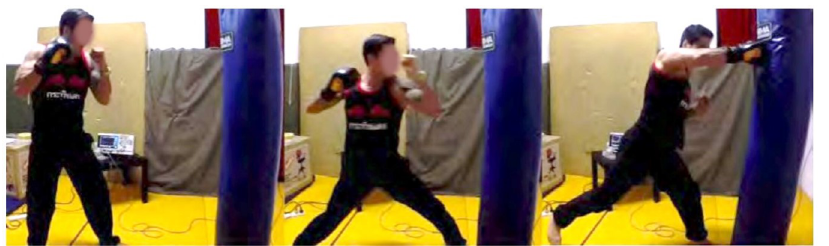
Figure 11. Hapkido right-cross punch motion.